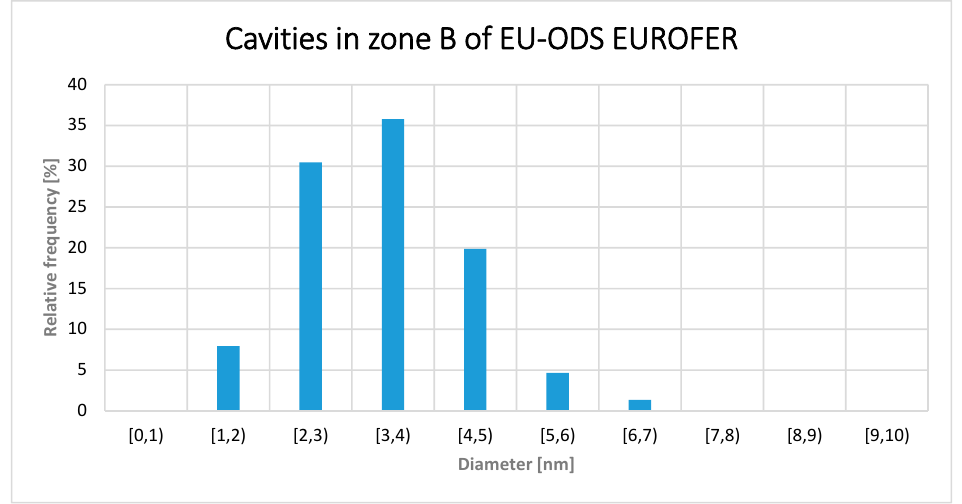
Figure 14. Cavity diameter distribution within the zone B of EU-ODS EUROFER (548 to 619) and annealed at 450 °C for 100 h.